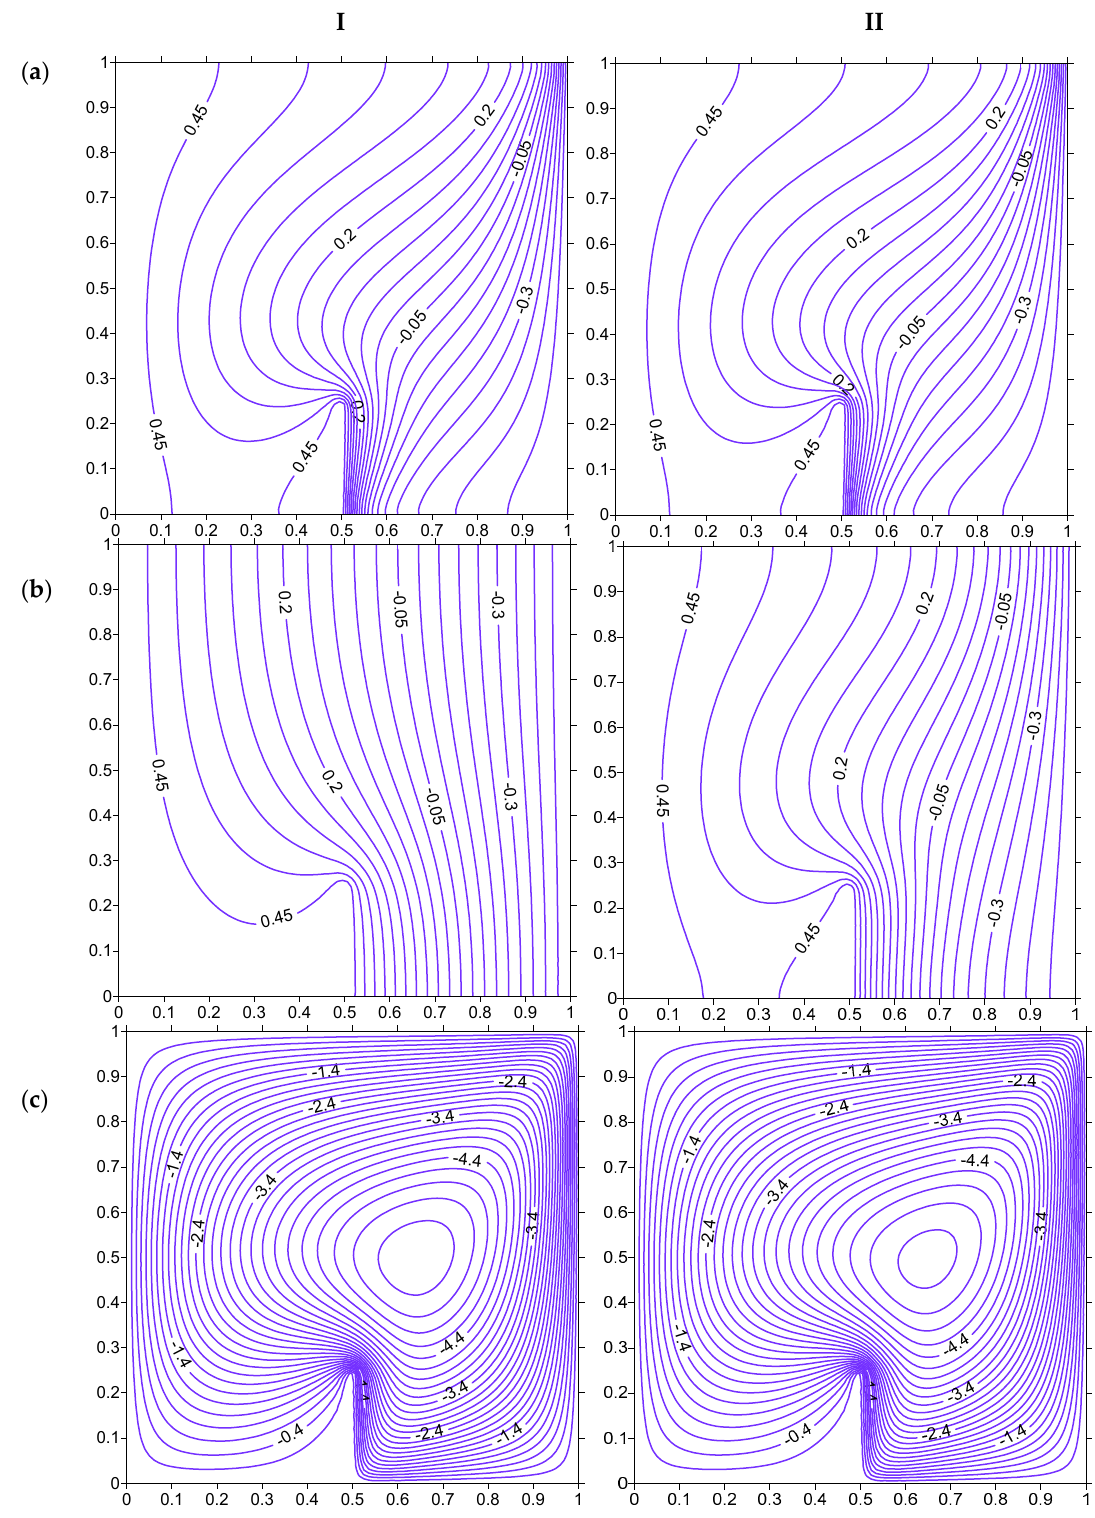
Figure 24. Isotherms (( a ) Fluid, ( b ) Solid), and streamlines ( c ), at HH = 25%, H = 5, Kr = 1, Rd = 0 for strip at x = 0.5. ( I ) Ra = 100. ( II ) Ra =